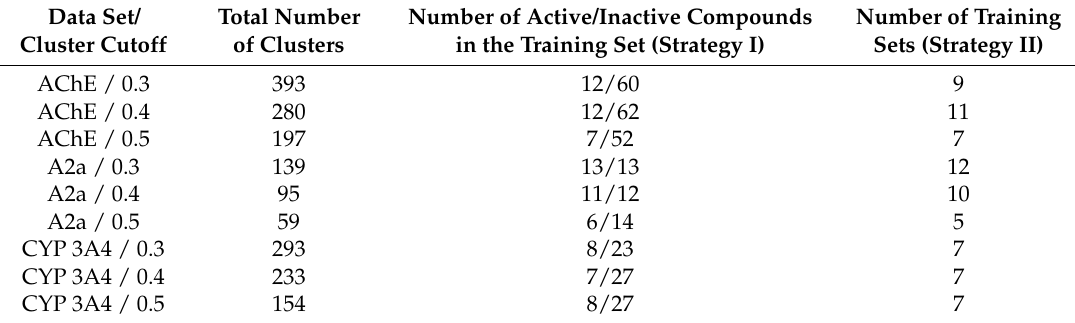
Table 2. Results of data set clustering and training sets size and number.